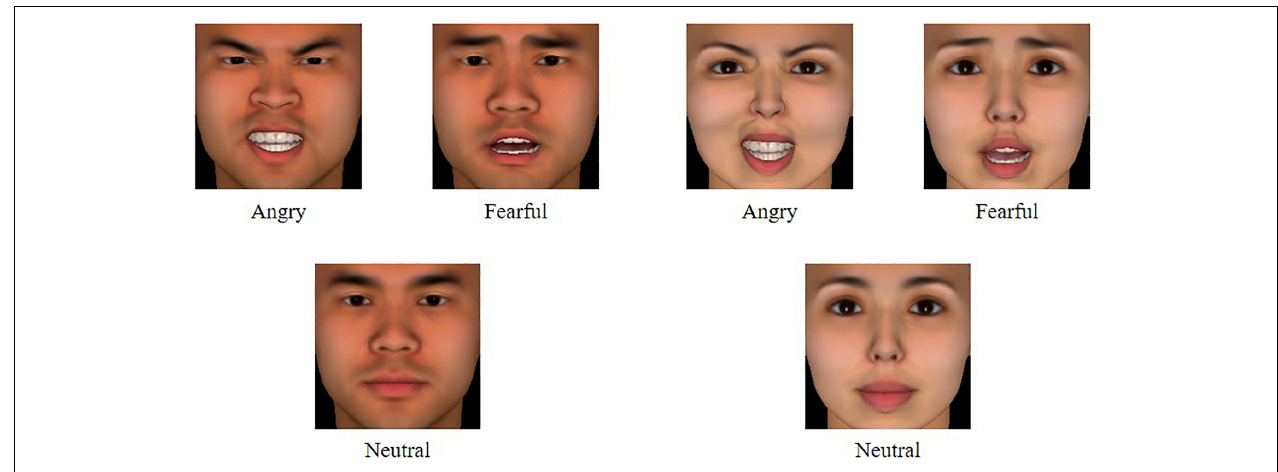
FIGURE 1 | Examples of stimuli used in the critical blocks. The complete target stimuli are available from Supplementary Material .